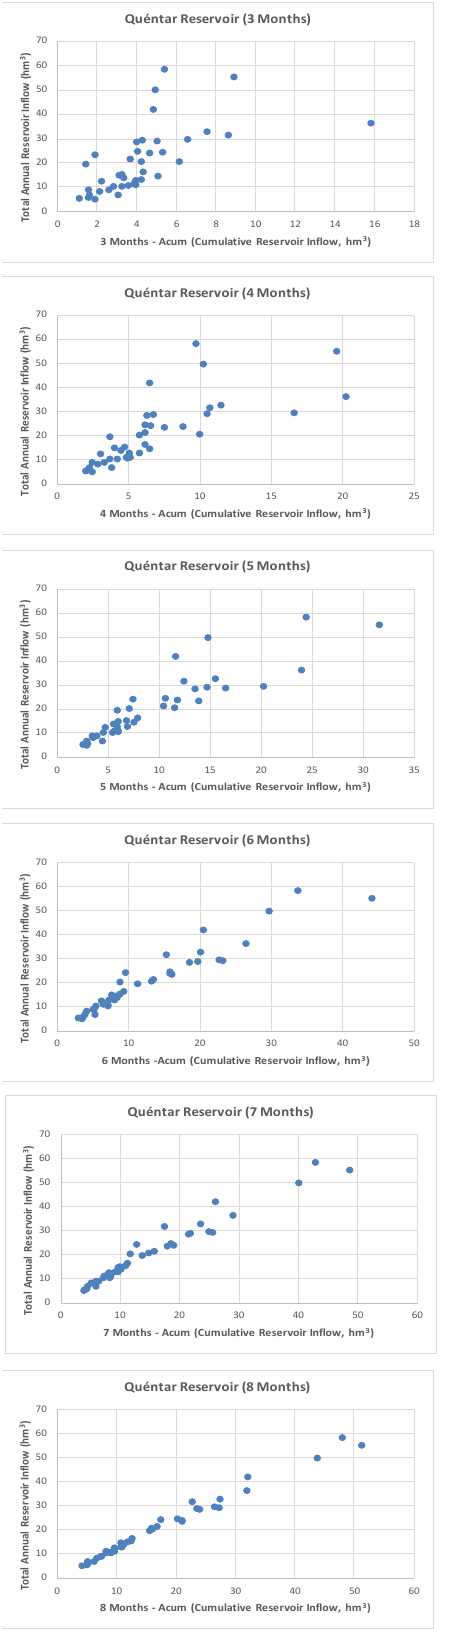
Figure 6 . Quéntar reservoir: Regression analysis for the first three, four, five, six, seven, and eight months using the cumulative monthly reservoir inflow and precipitation.